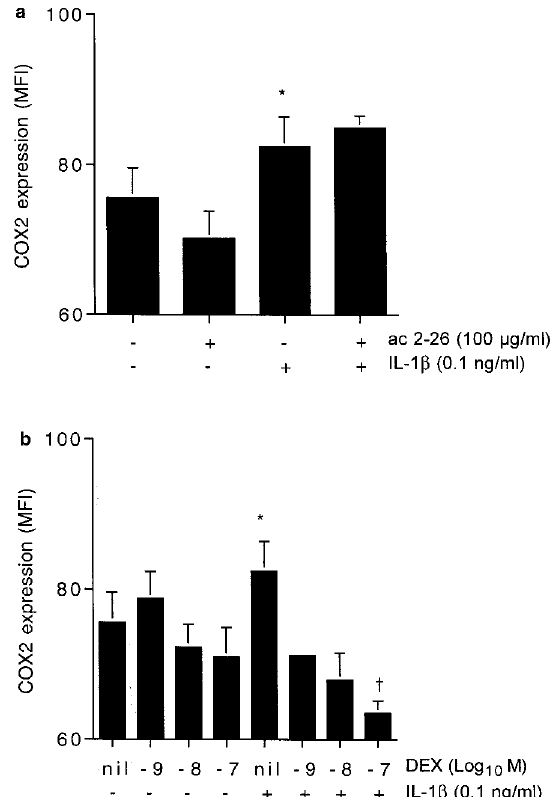
FIG. 6. Intracellular COX2 expression in human FLS. Human FLS were treated with IL-1 b (0.1ng/ml), and/or (a) annexin I ac 2–26 (100 m g/ml), (b) DEX (10 -9 –10 -7 M) for 8h. Intracellular COX2 was detected by permeabilization flow cytometry and expressed as mean fluorescence intensity (MFI) after sub- traction of MFI obtained with the negative controlmAb. Values are mean ± SEM of 4 experiments. * p < 0.01 versus untreated FLS, p < 0.01 versus IL-1 b -treated